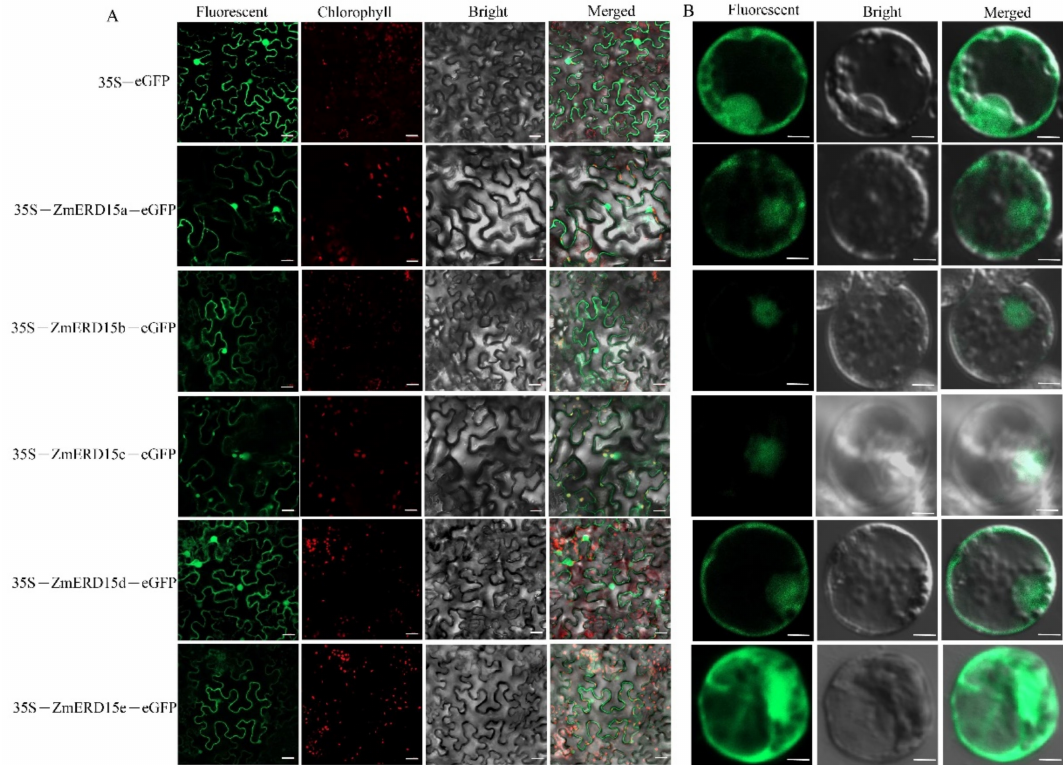
Figure 4. Subcellular localization. ( A ) Localization of ZmERD15s in tobacco leaves. The scale bar is 20 µ m. ( B ) Localization of ZmERD15s in maize protoplast. The scale bar is 50 µ m. Each ZmERD15 was amplified by PCR without a stop codon and fused to eGFP under the control of a 35S promoter. 35S-eGFP was used as the